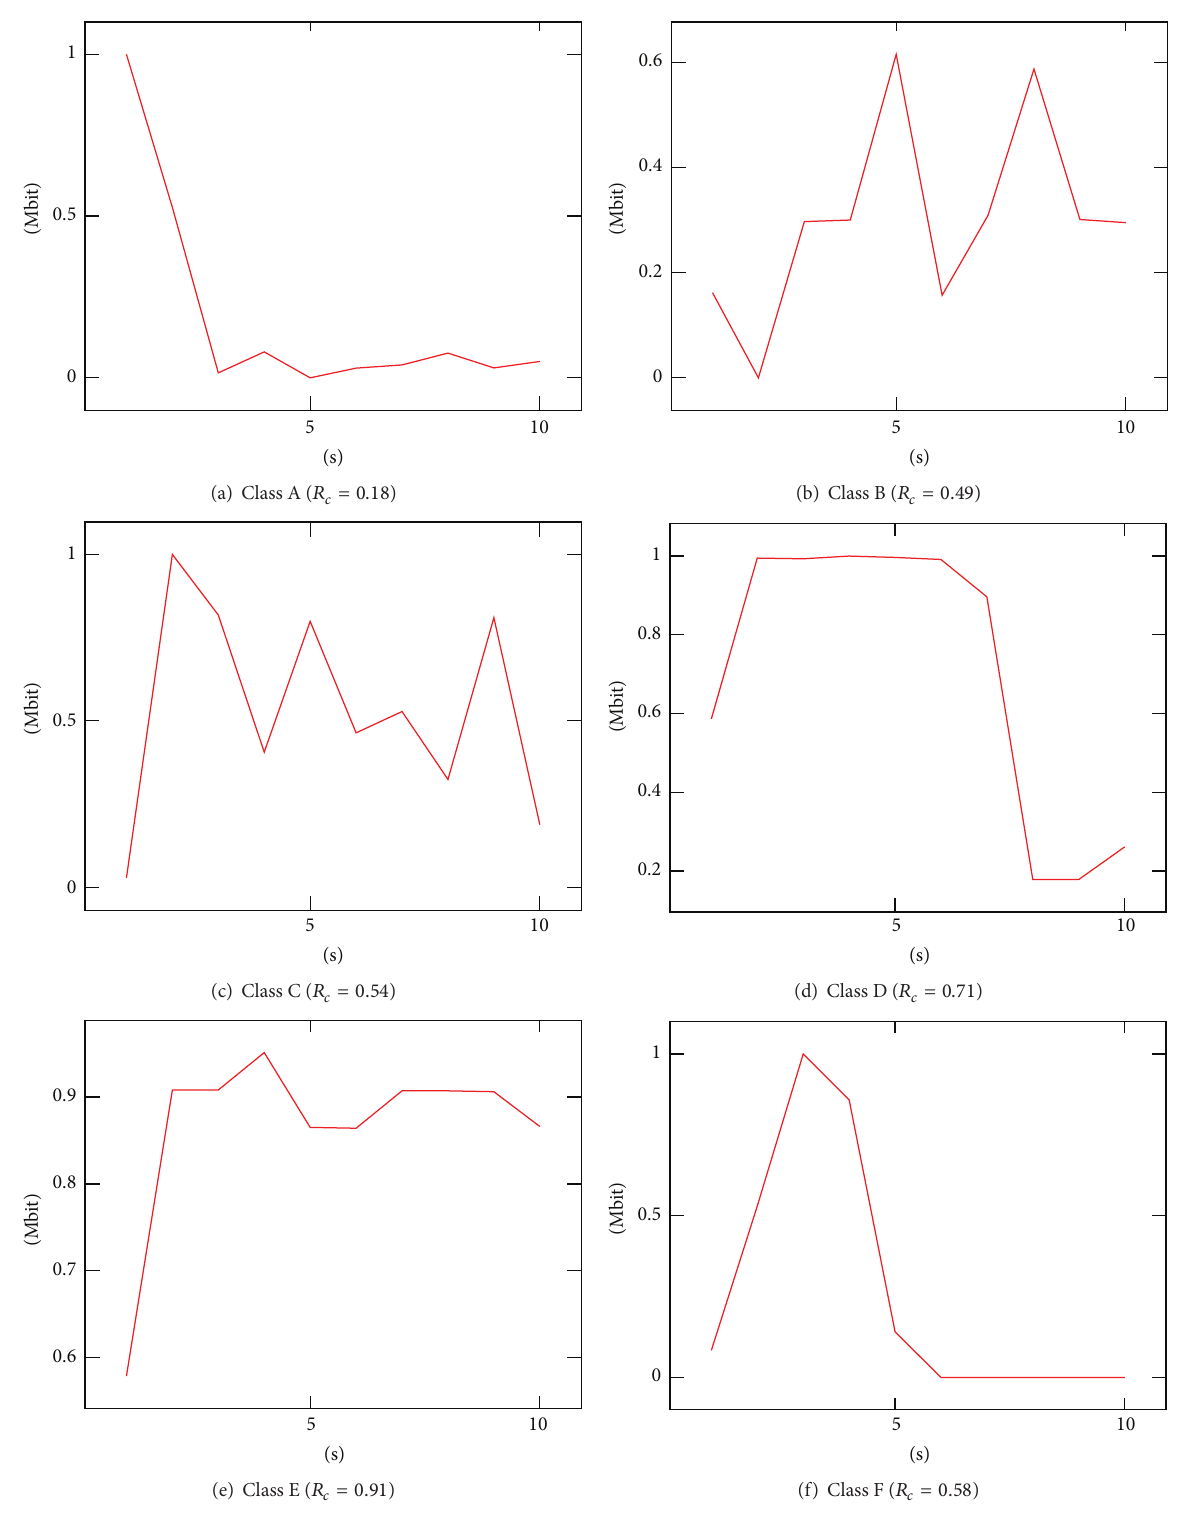
Figure 3: Examples for the SCBP